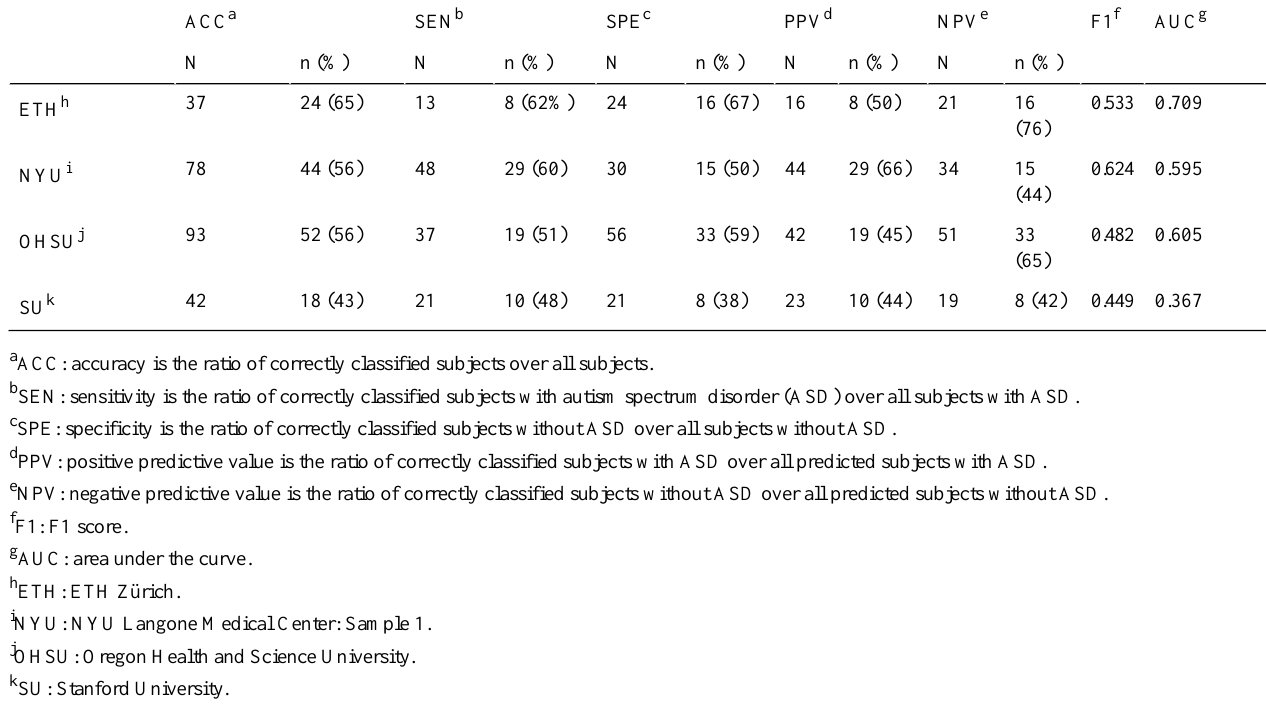
Table 4. Classification performance using scale-invariant feature transform and support vector machine on the second edition of the Autism Brain Imaging Data Exchange datasets. Performance using scale-invariant feature transform and support vector